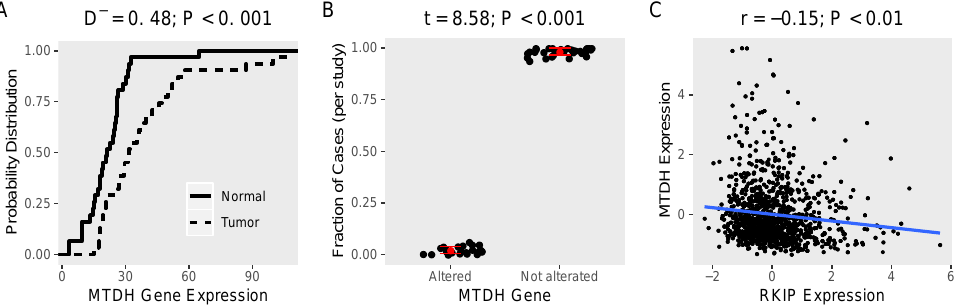
Figure 1. Expression and alterations of MTDH gene in cancer tissues. Gene expression data of human samples and matched normal tissues ( n = 31) were obtained from TCGA and GEPIA, respectively. ( A ) Empirical cumulative distribution functions (ECDF) of expression of MTDH in cancer ( dot line ) and normal tissues ( solid line ) were calculated. The maximum distance (D − ) between the curves was calculated using Kolmogorov–Smirnov test. ( B ) The average fraction of cases ( n = 10,953) with or without alterations (mutation, fusion, amplification, or deletion of the MTDH gene in cancer tissues ( n = 31) from TCGA. The difference between altered and not altered were tested using t-test. ( C ) A scatter plot of the MTDH and RKIP expression in patient tissue ( n = 1084) from TCGA, Breast Cancer cohort. Pearson’s correlation coefficient (r) was used to evaluate the correlation between the two genes and test for